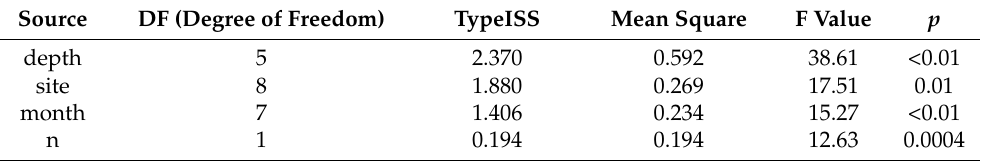
Table 2. ANOVA analysis for each source of TP in sediment.